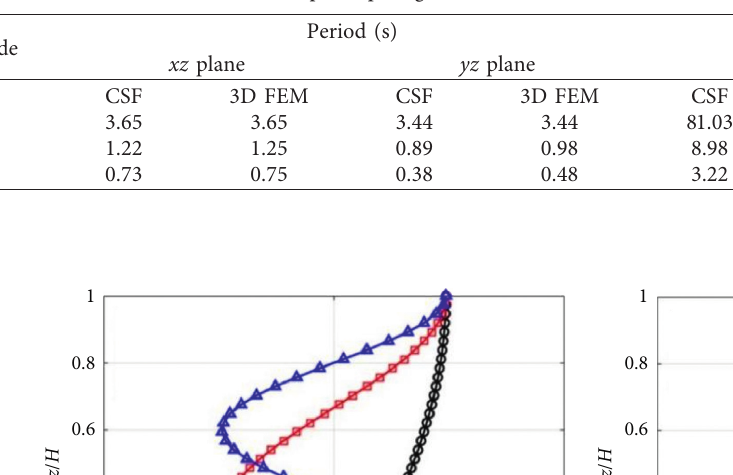
Figure 8: Mode shape of the first mode of vibration: 3D FEM vs. CSF model [55]. (a) xz plane. (b) yz plane. Table 7: Periods and participating mass ratios of the fixed-base building: CSF model vs. 3D FEM [55].